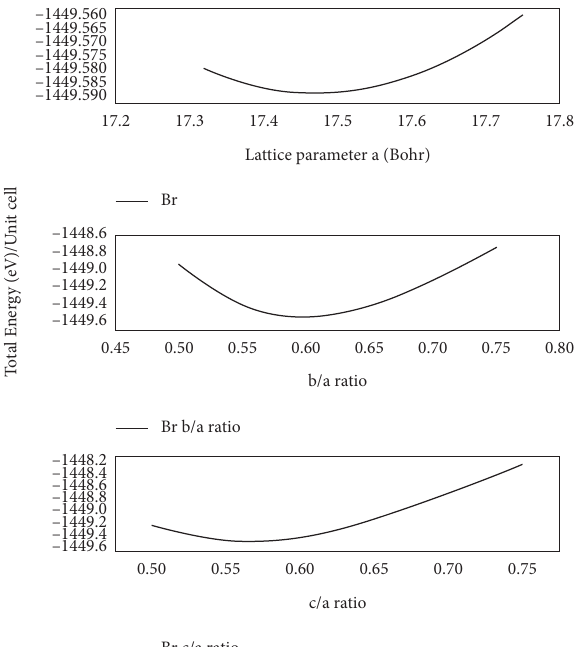
Figure 3: Structural optimization of